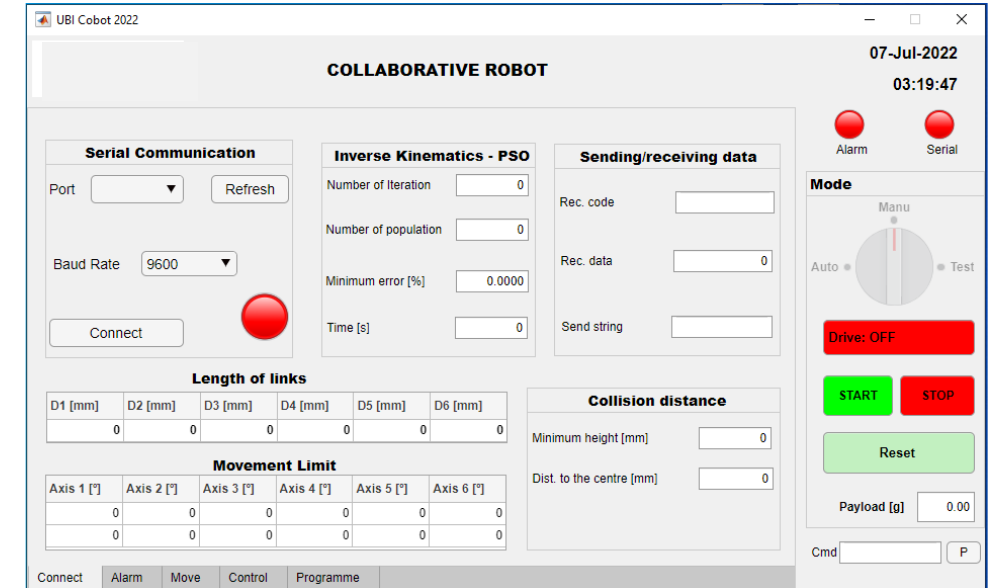
Figure 12. User interface; connect menu.